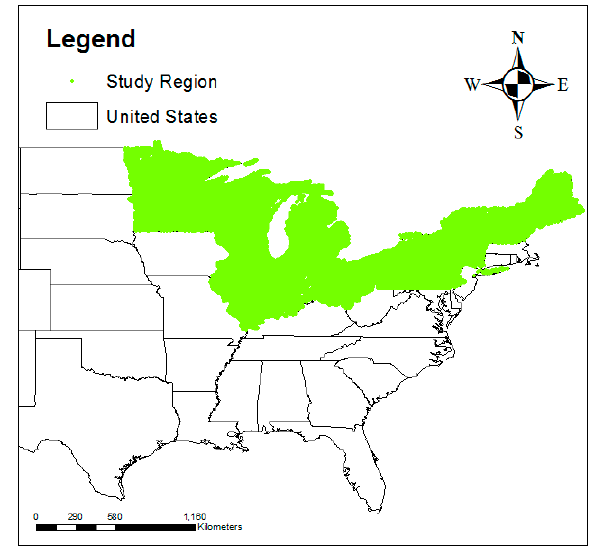
Figure 1. Location of study region across the Northern US.